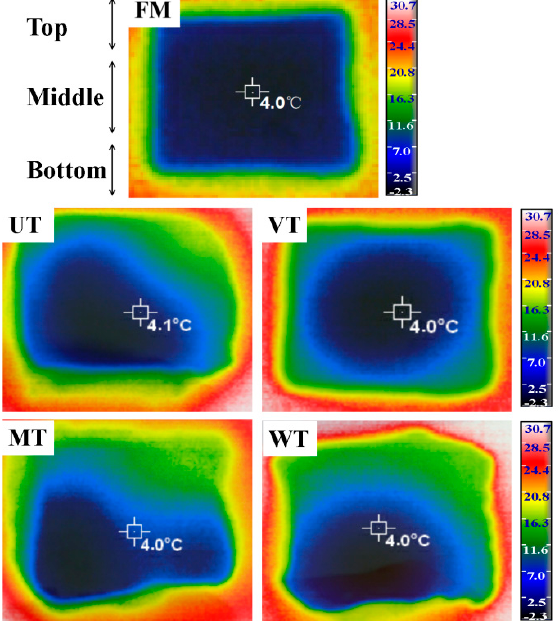
Figure 2. Change in internal temperature distribution of porcine longissimus dorsi induced by thaw- ing methods. FM, fresh meat; UT, ultrasonic thawing (20 °C); VT, vacuum thawing (25 °C); MT, microwave thawing; WT, water immersion thawing (14 °C).